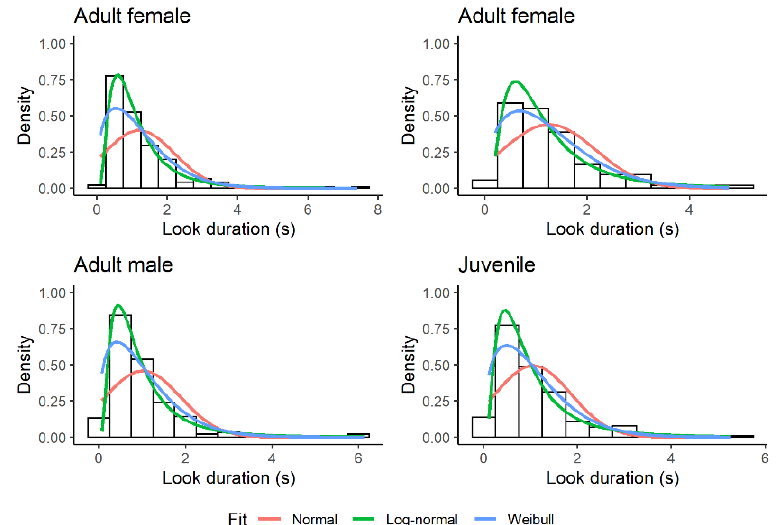
Figure 2. Relative fit of three theoretical distributions to the duration of looks (s) during sentinel bouts in four different Florida scrub-jay sentinels. Fit to the negative exponential distribution is not shown for clarity. The negative exponential distribution is an ever-decreasing function with a peak at the smallest values.